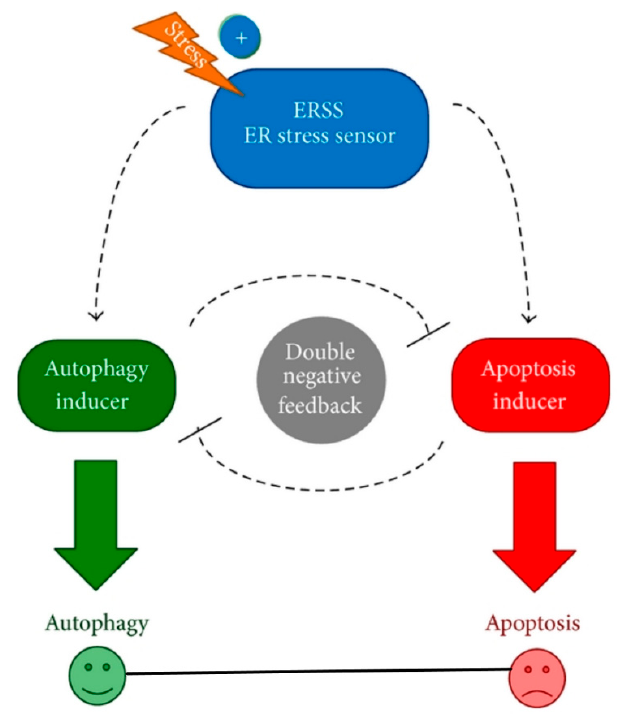
Figure 3. The relationship between apoptosis and autophagy . The schematic model of autophagy-apoptosis crosstalk during ER stress. The autophagy inducer, the apoptosis inducer, and the ER stress sensor (ERSS) are denoted by isolated green, red, and blue boxes, respectively. Dashed line shows how the molecules can influence each other, while blocked end lines denote inhibition. Reprinted by permission from Holczer et al., 2015 [46]